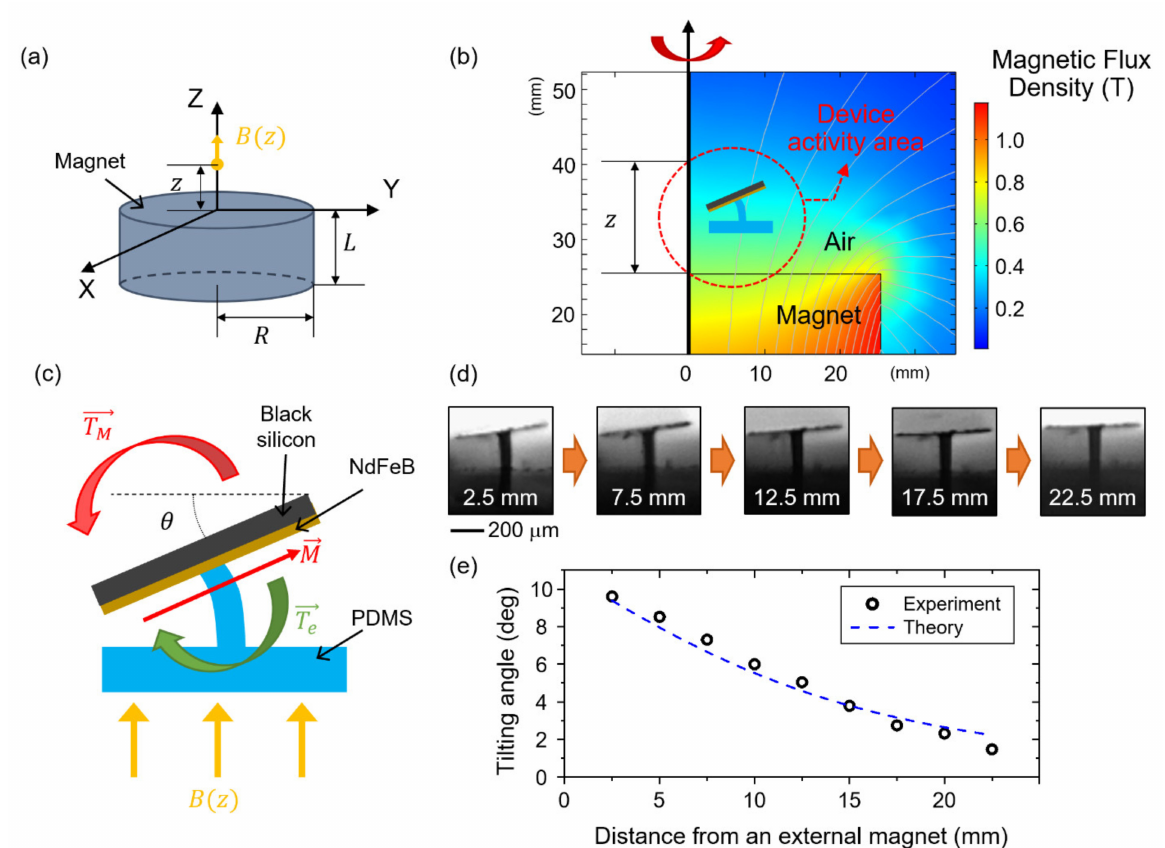
Figure 6. ( a ) The dimension of an external magnet where its z-axis magnetic flux density is indicated. ( b ) A fringe plot of a magnetic flux density from the external magnet. ( c ) Schematic illustration of two competing torques applied to a strip combined with an elastomer ridge. ( d ) Experimentally captured sequential photos of the tilted strip at different distances from the external magnet. ( e ) A graph of theoretically calculated and experimentally measured tilting angles as a function of the distance from the external